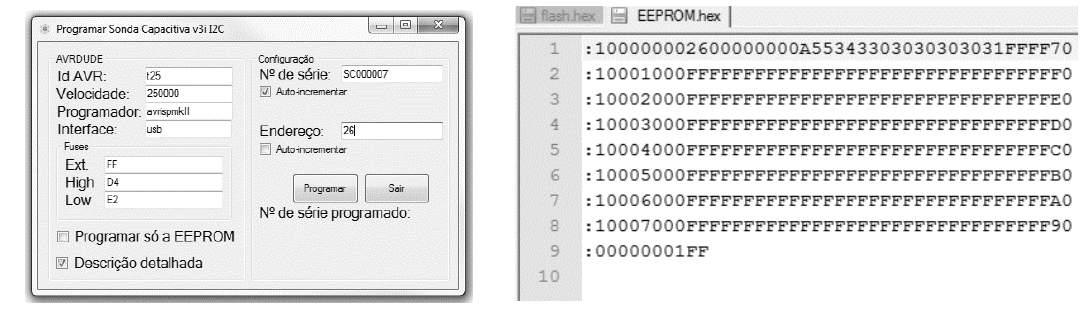
Figure 27. Programming application for the capacitive probe.